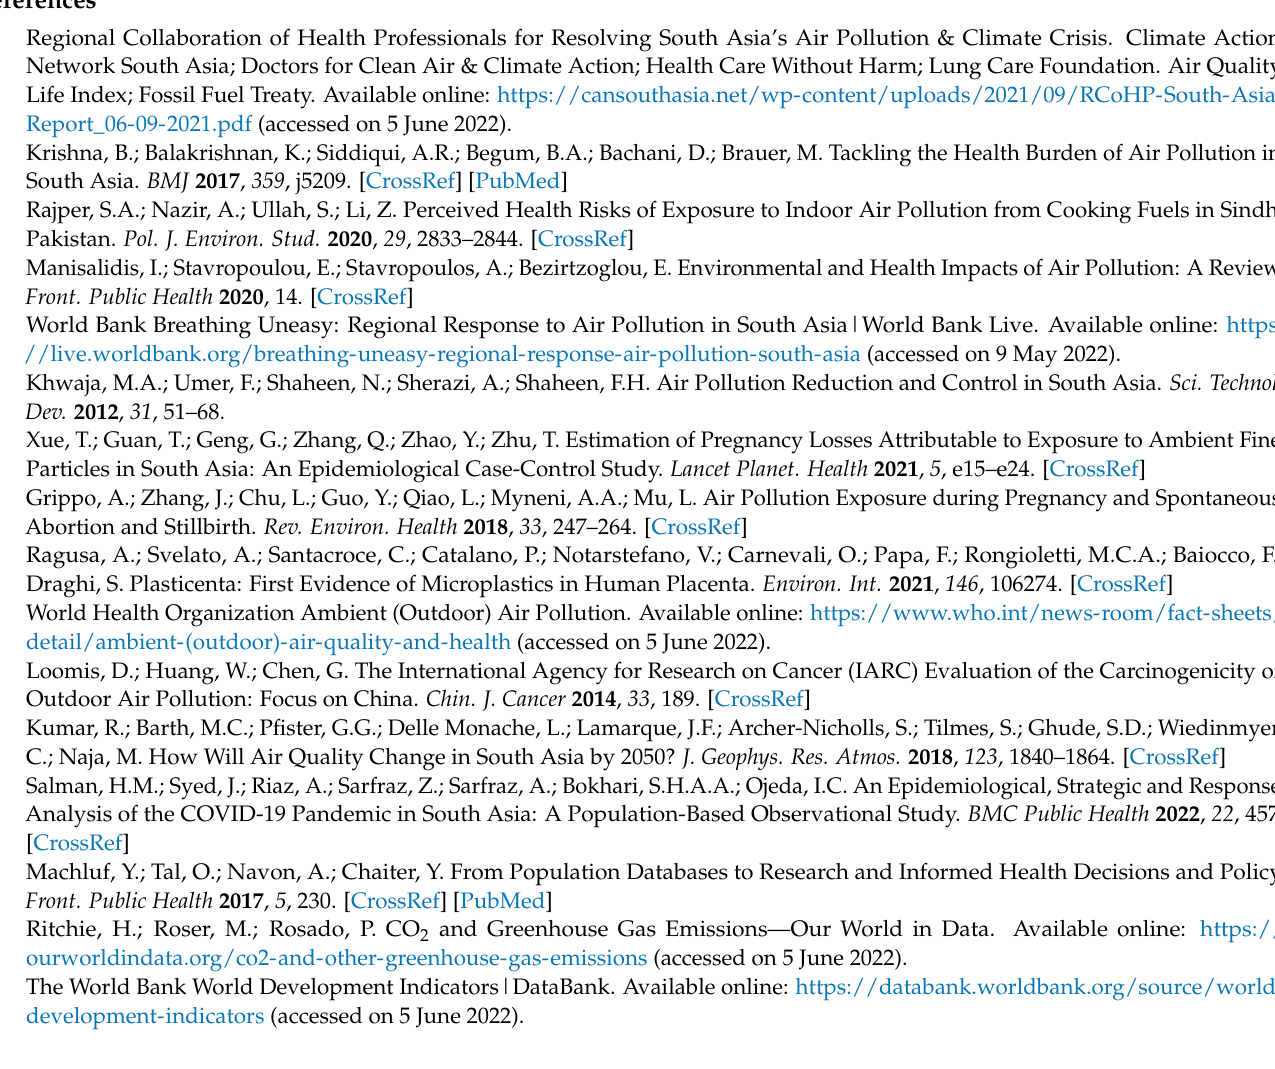
Supplementary Table S2: Air Pollution Data; Supplementary Table S3: Sustainability Trends